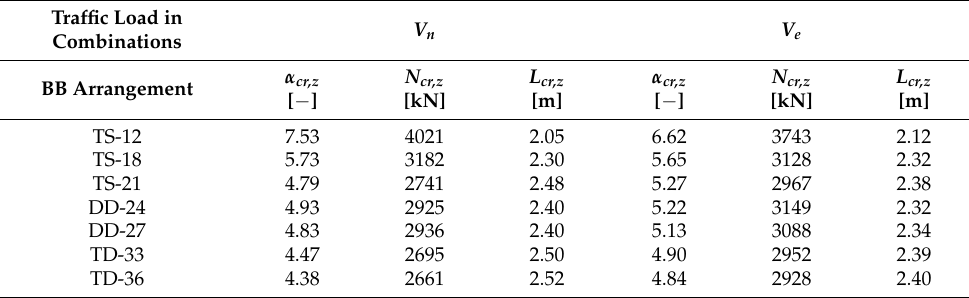
Table 2. Buckling parameters of out-of-plane buckling of the top chords. Traffic Load in Combinations BB Arrangement